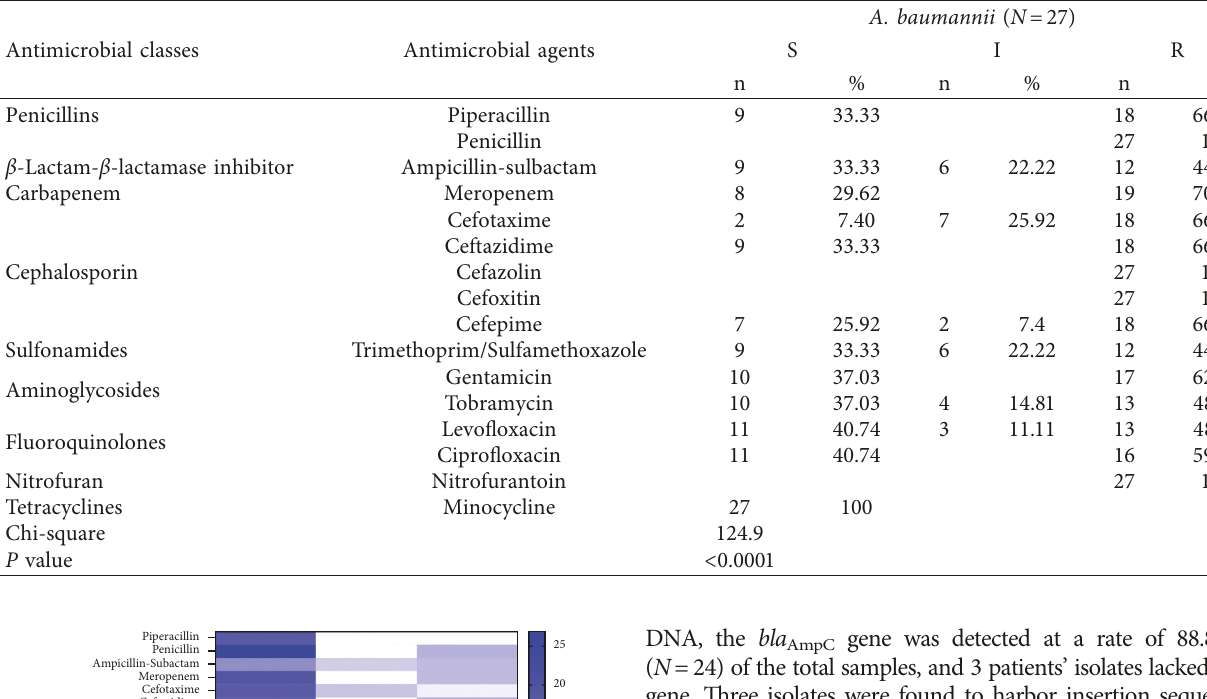
DNA, the bla AmpC gene was detected at a rate of 88.88% ( N 24) of the total samples, and 3 patients’ isolates lacked the (cid:31) gene. Three isolates were found to harbor insertion sequence